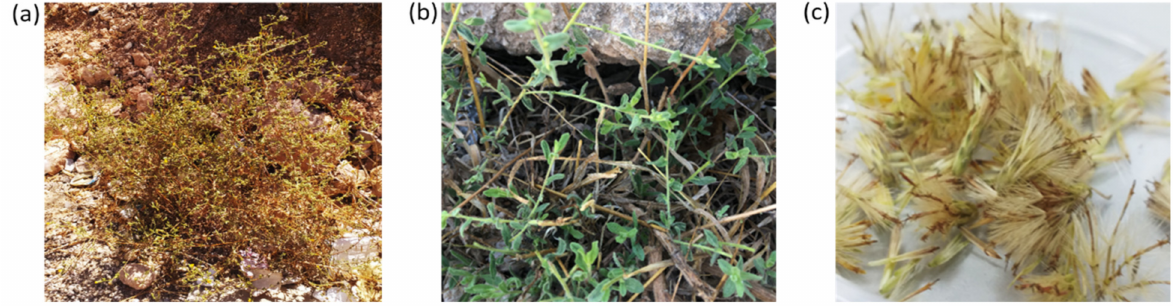
Figure 1. ( a ) C. montanus (Vahl.) Brullo plant growing in the wild; ( b ) close view of C. montanus shoots in the wild; and ( c ) C. montanus seeds collected from the wild